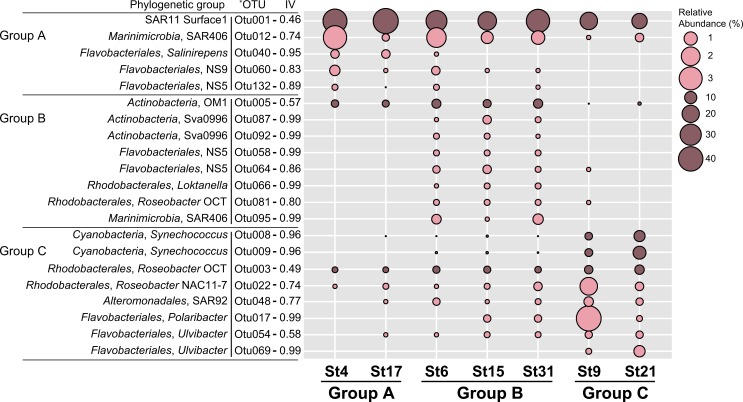
Bubble plots showing the relative abundance of indicator OTUs in each of the 3 groups of the sampling stations.The size of the bubble indicates the relative abundances (%) of each OTU in each of the 7 sampling stations. Indicator values are displayed next to each OTU. Consensus taxonomic groups of each indicator OTU are presented on the left side of bubble plots. * OTUs with IV > 0.4 and p < 0.05.